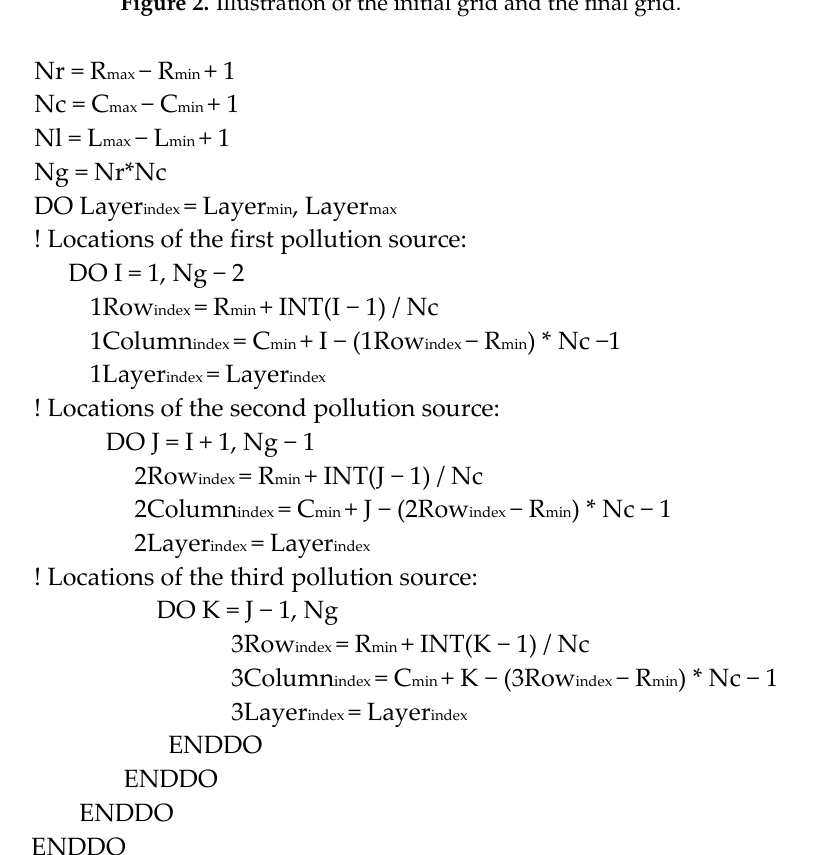
Figure 3 . Fortran code of Grids Traversal GT algorithm for above example 156 Figure 3. Fortran code of the Grids Traversal algorithm for the above Figure 3. Fortran code of the Grids Traversal algorithm for the above example.